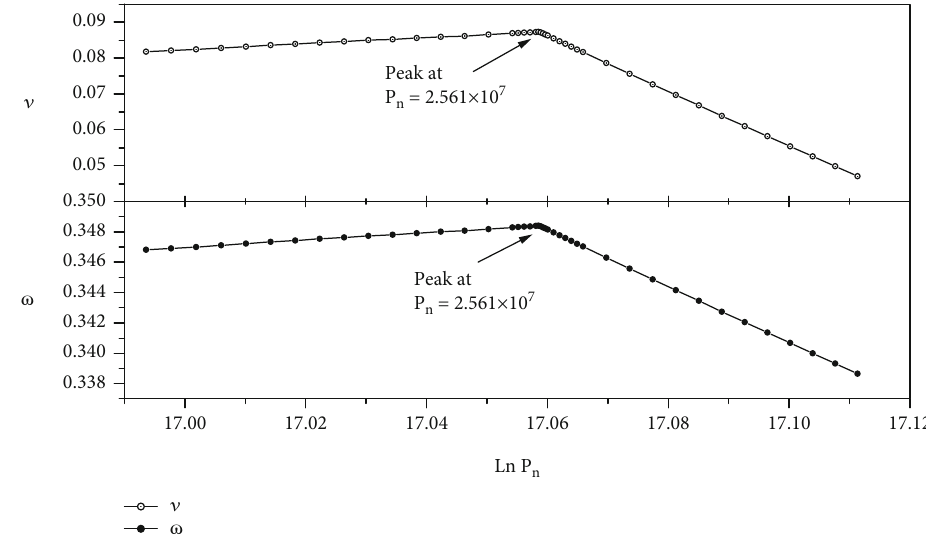
Figure 10: (a) The relation between the natural logarithm of the accumulated prime numbers and the inverse χ 2 parameter ν from 24 million to 27 million primes with small steps. (b) The relation between the natural logarithm of the accumulated prime numbers and the Brody parameter ω from 24 million to 27 million primes with small